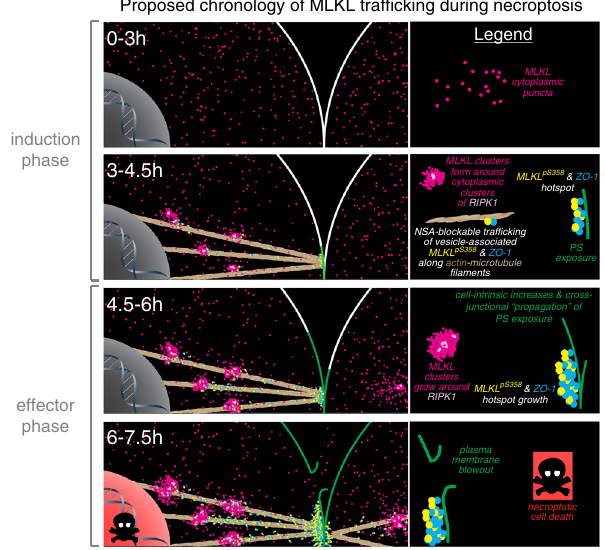
Fig. 9 Model of TNF-induced epithelial cell necroptosis